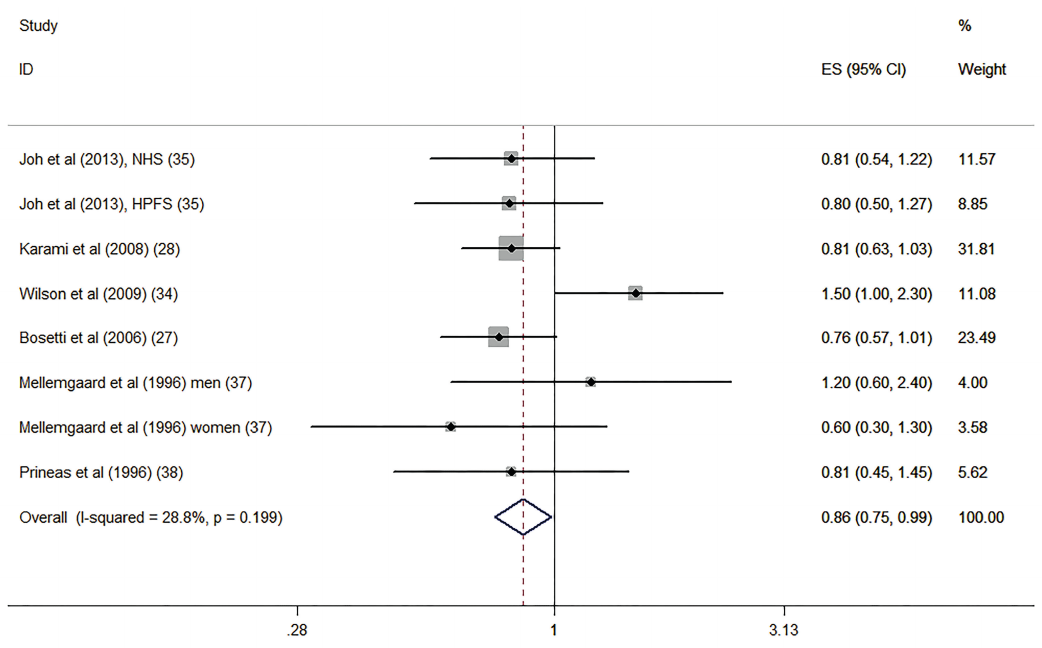
Figure 3 - Forest plot for dietary vitamin D intake and risk of renal cell